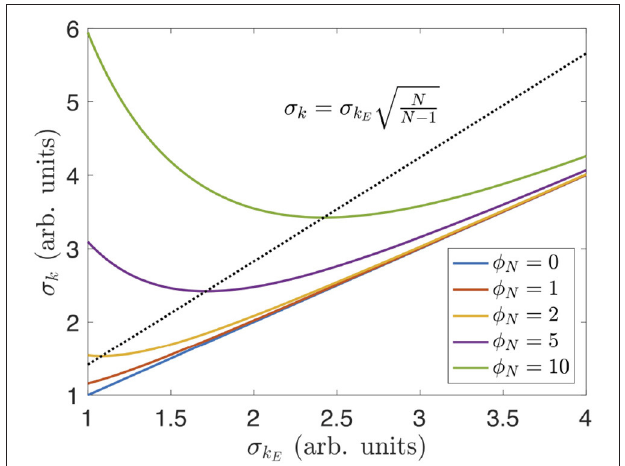
FIGURE 6 | Total bandwidth vs. σ k for different N 2 phase distortions. The E = minimum total bandwidth follows the dashed curve if φ N is large enough (i.e., if Equation 22 is satisfied). Otherwise the minimum is set by the minimum possible value of σ k ( σ k 1, in this example for φ N 0 and 1). E E = =